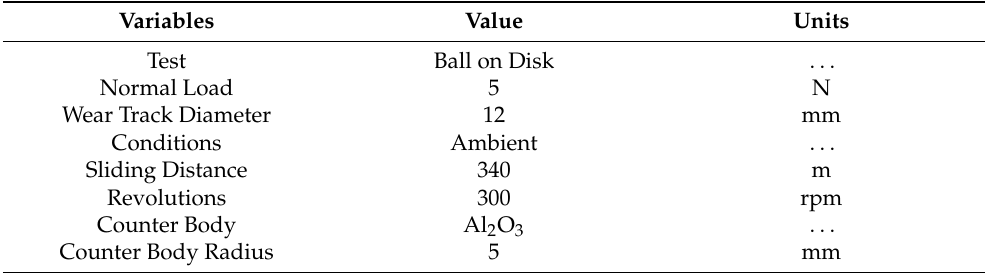
Table 4. The process variables utilized to evaluate wear resistance using the ball-on-disc tribometer on the sample fabricated using the CMT—based WAAM